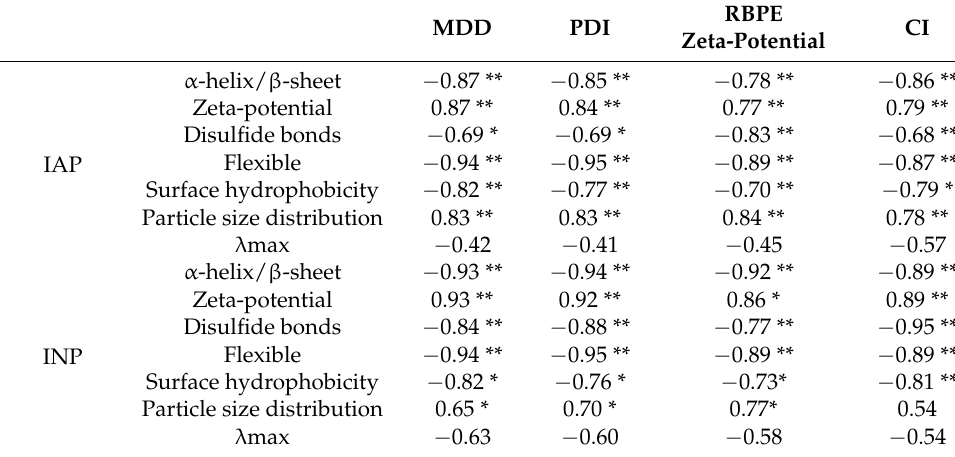
Table 3. Correlation of the stability of RBPE prepared from RB with different rancidity extents and the structural characteristic of IAP and